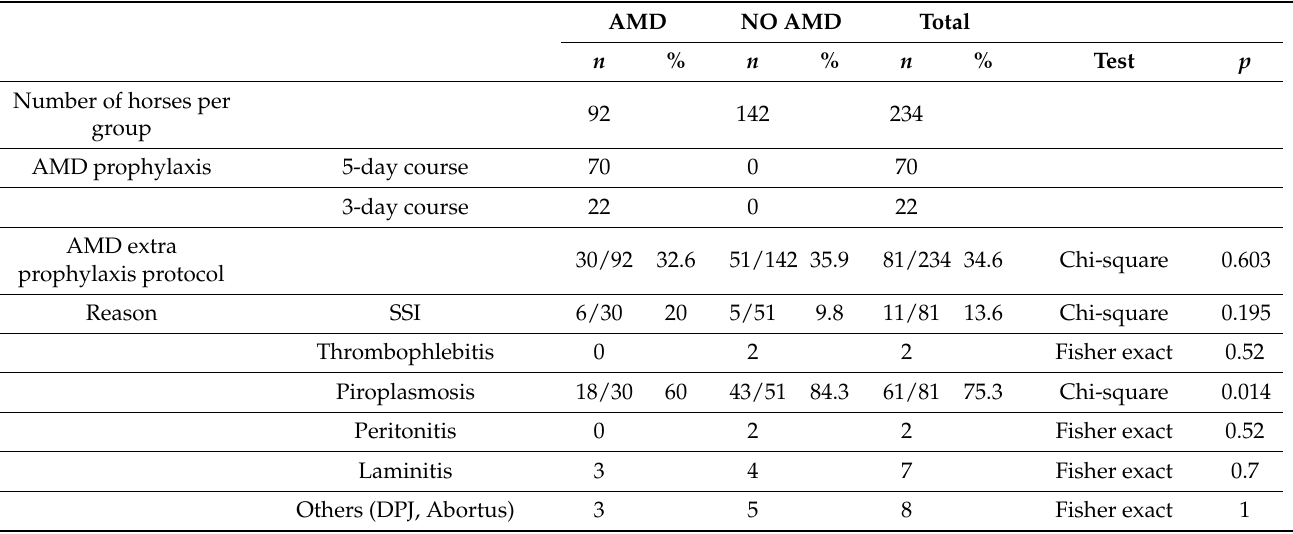
Table 2. Data of antimicrobial administration in the postoperative period and reason behind this approach. (SSI: surgical site infection; DPJ: duodenitis–proximal jejunitis).